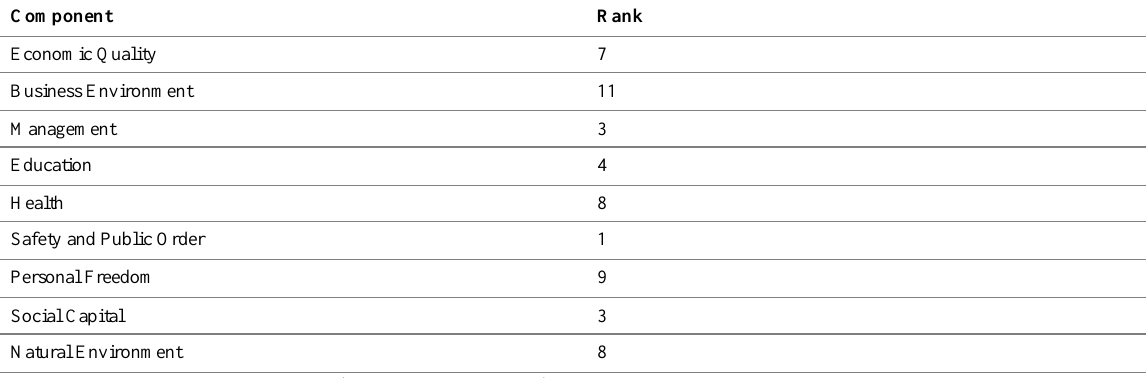
Table 2: Norway’s Legatum Prosperity Index in 2018 Rank